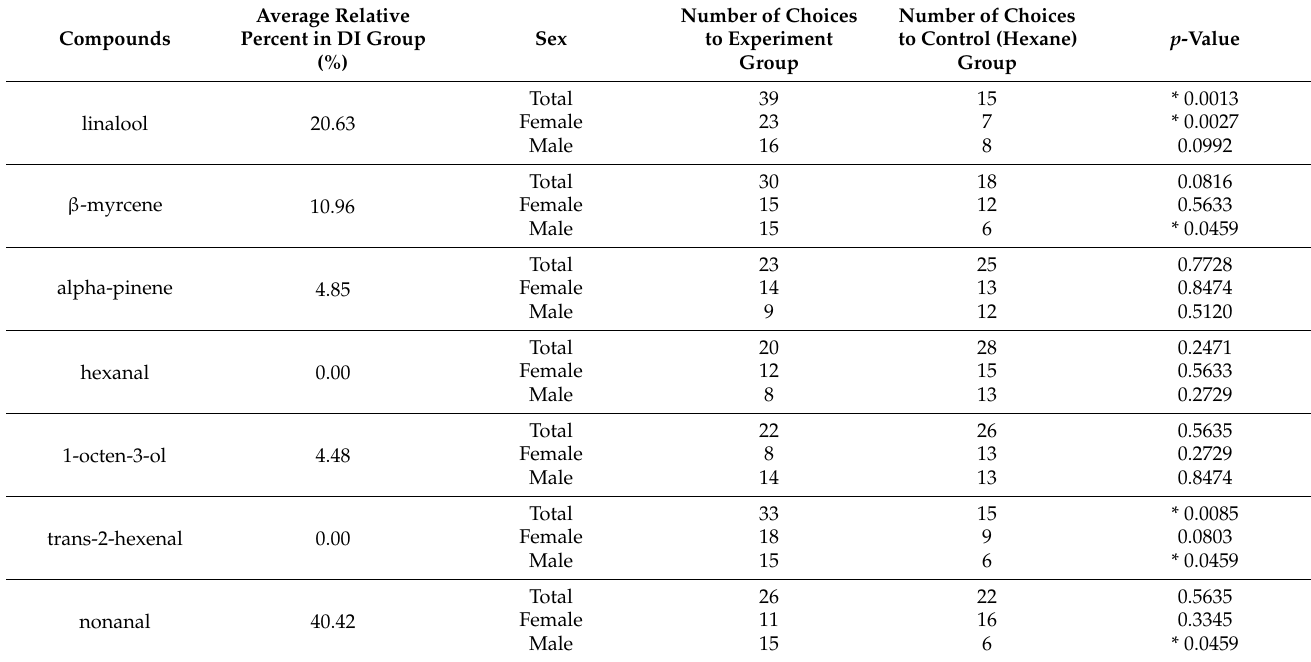
Table 4. Sclomina erinacea individuals’ preference in Y-olfactometer experiment to seven kinds of VOCs produced by Hypolepis punctata versus hexane.